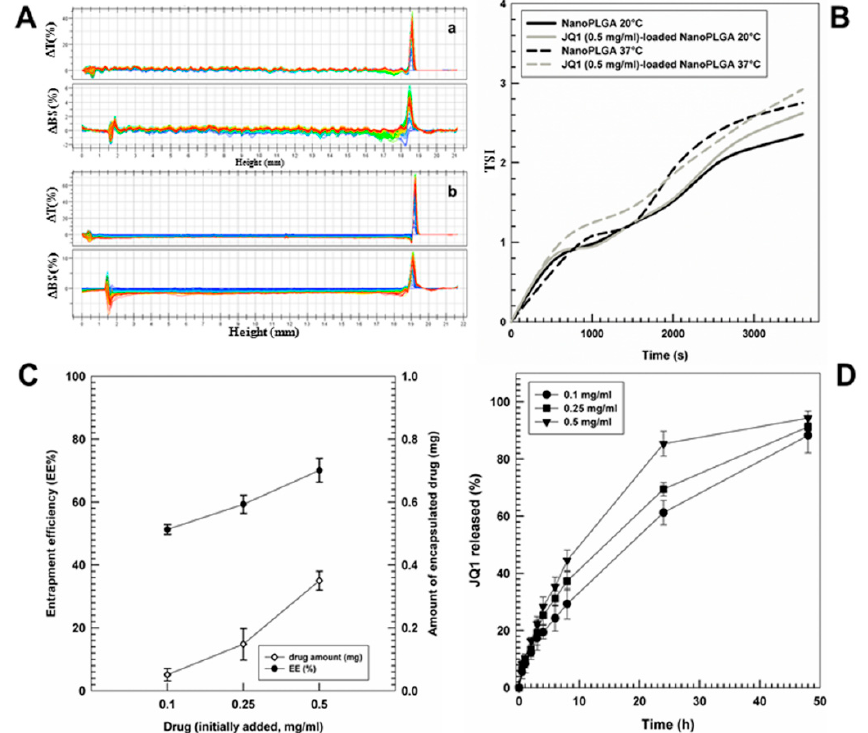
Figure 1. Evaluation of the physical stability of the various nanoformulations. ( A ) Transmittance ( ∆ T) and backscattering ( ∆ BS) profiles of ( a ) empty PLGA nanoparticles and ( b ) nanosystems prepared with JQ1 (0.5 mg / mL) using Turbiscan Lab. Results representative of three independent experiments are shown. ( B ) Turbiscan Stability Index (TSI) profiles of PLGA nanoparticles as empty formulation